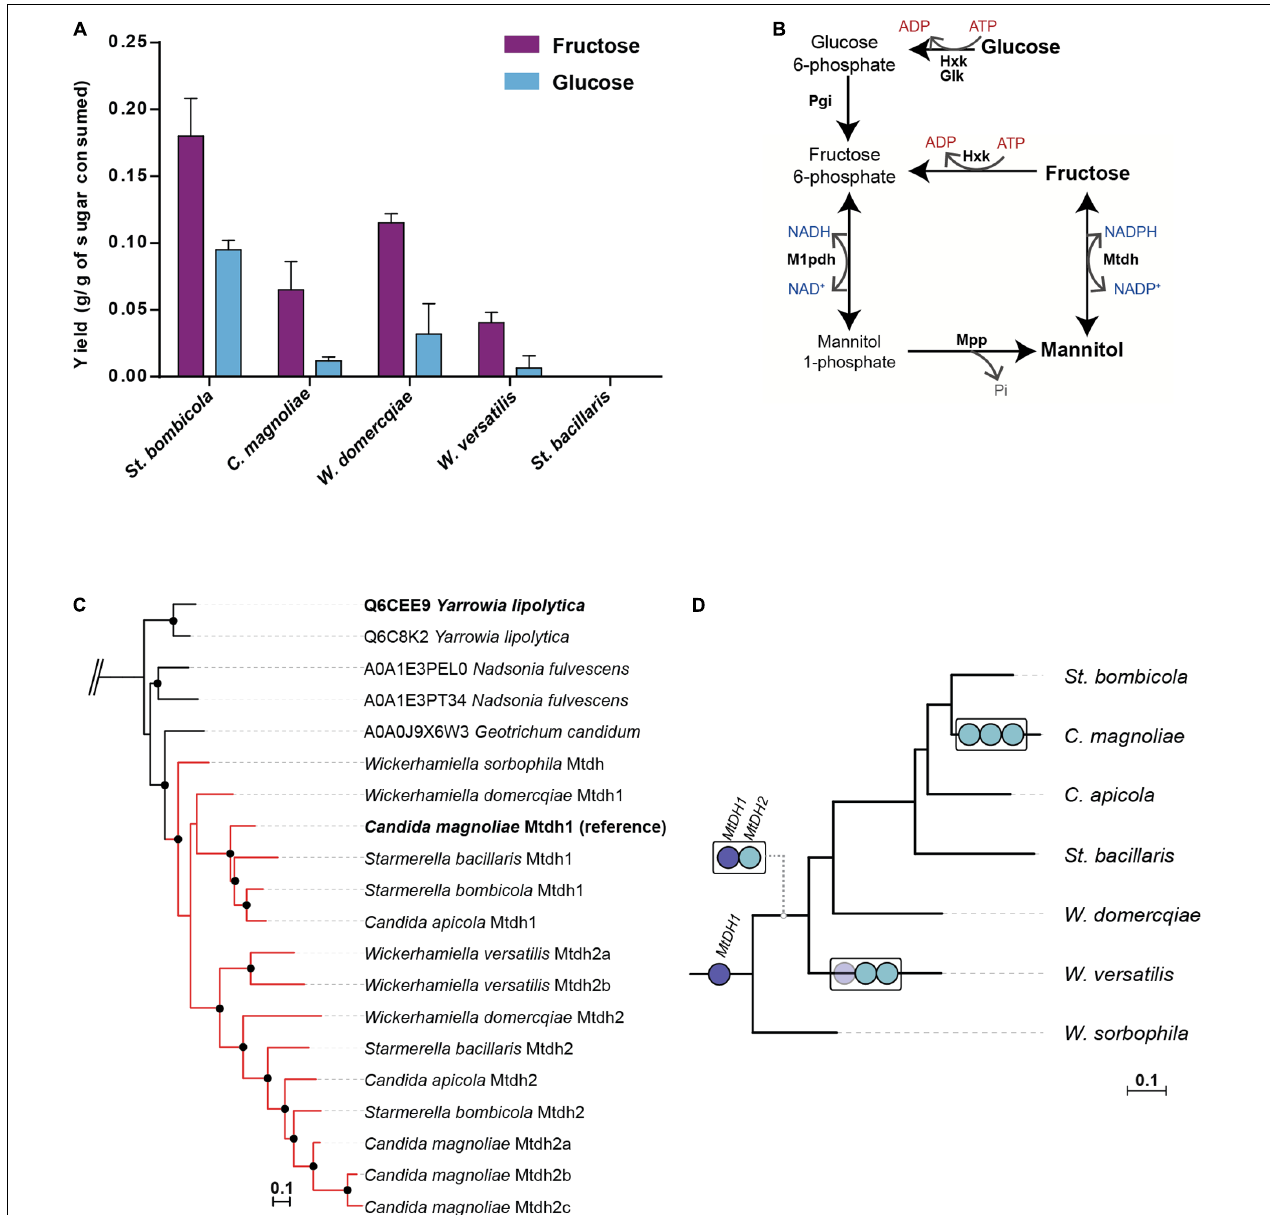
FIGURE 1 | Mannitol production and phylogenetic analyses of mannitol-related genes in W/S-clade species. (A) Mannitol yields determined after 72–150 h of growth on YP medium supplemented with 10% (w/v) glucose or 10% (w/v) fructose at 30 ◦ C in several W/S-clade species ( Starmerella bombicola , Candida magnoliae , Starmerella bacillaris , Wickerhamiella domercqiae and Wickerhamiella versatilis ). Assays were performed in duplicate and the error bars represent the standard deviation. (B) Mannitol biosynthetic pathways in Fungi as described by Hult et al. (1980). Glk – Glucokinase, Hxk – Hexokinase, Pgi – Phosphoglucose isomerase, Mtdh – mannitol dehydrogenase, Mpp – mannitol-1-phosphate phosphatase, M1pdh – mannitol-1-phosphate dehydrogenase. (C) Pruned Maximum Likelihood (ML) phylogeny of Mtdh-like proteins using the top 750 hits (UniprotKB database) to St. bombicola Mtdh1. Branches with support higher than 95% are indicated by black dots. W/S-clade proteins are shown in red. Complete phylogeny can be accessed in Figshare doi: 10.6084/m9.figshare.9959693. (D) Schematic representation of the phylogenetic relationships between W/S-clade species based on Gonçalves et al. (2018). MtDH genes are represented by blue circles (dark blue- MtDH1 , light blue- MtDH2 ). The duplication events are represented by white boxes in the respective branches in which they were assumed to have occurred. In W. versatilis , MtDH1 seems to have been lost (faded dark blue circle).